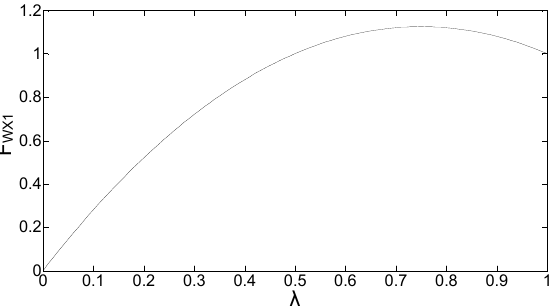
Figure 5. Diagram of the relationship between F W x1 W